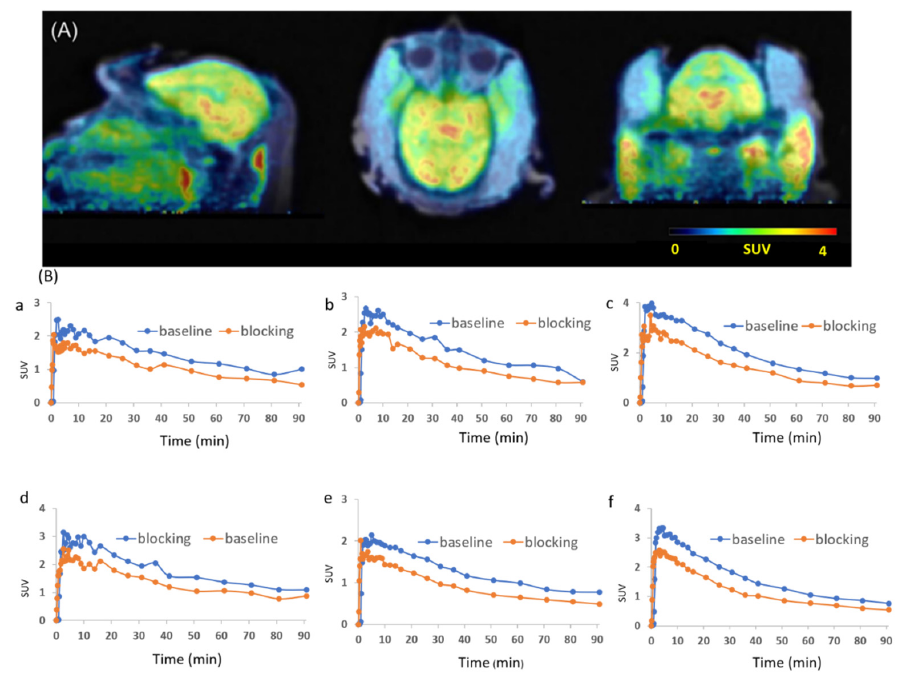
Figure 4. ( A ) Positron emission tomography (PET)-Magnetic resonance (MR) Imaging (macaque brain). Summed PET images (30–90 min after [ 11 C]CW24 injection) superimposed structural MRI from the same macaque. ( B ) Time − activity curves for brain regions of interest from baseline and blocking scans are shown (2.0 mg/kg IPSU) (a) hippocampus, (b) nucleus accumbens, (c) thalamus, (d) hypothalamus, (e) putamen and (f) cerebellum.